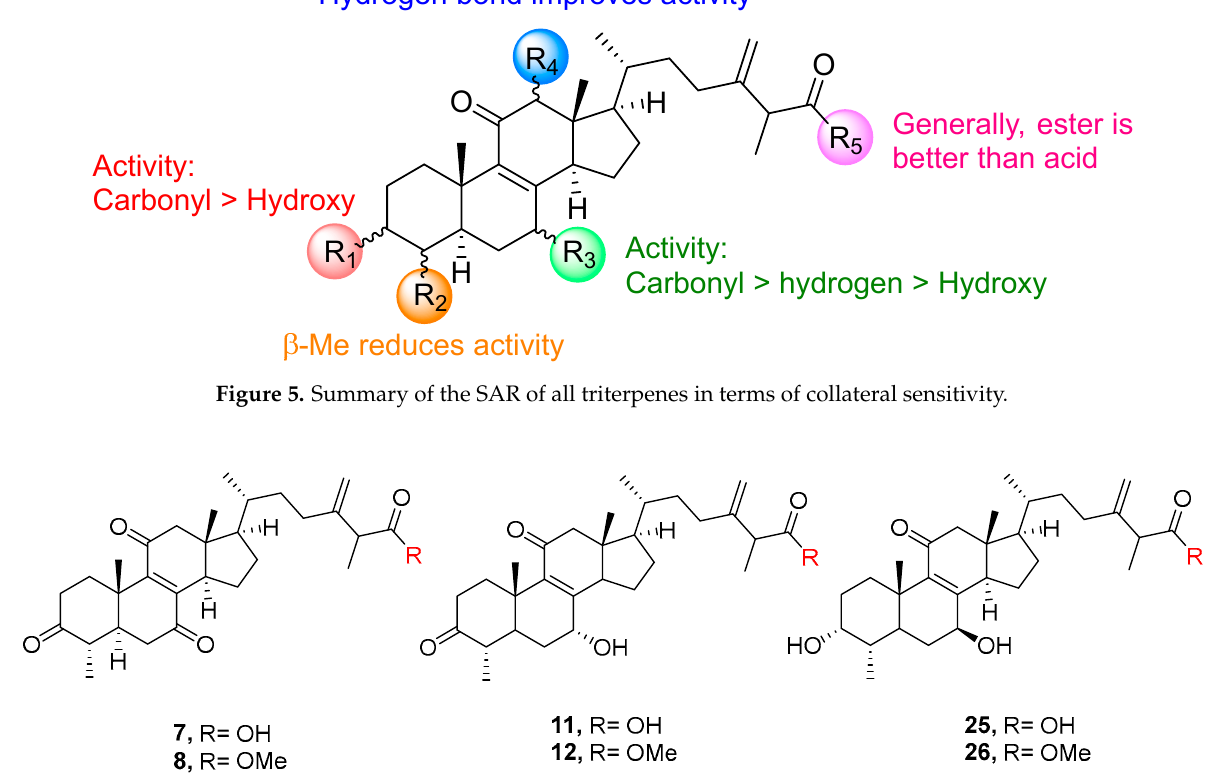
Figure 6. Structures of compounds 7 – 8 , 11 – 12 , and 25 – 26 .